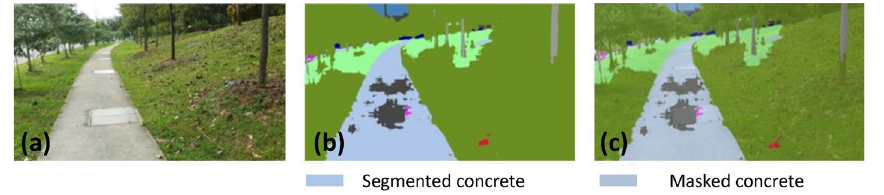
Figure 18. Online results: concrete.